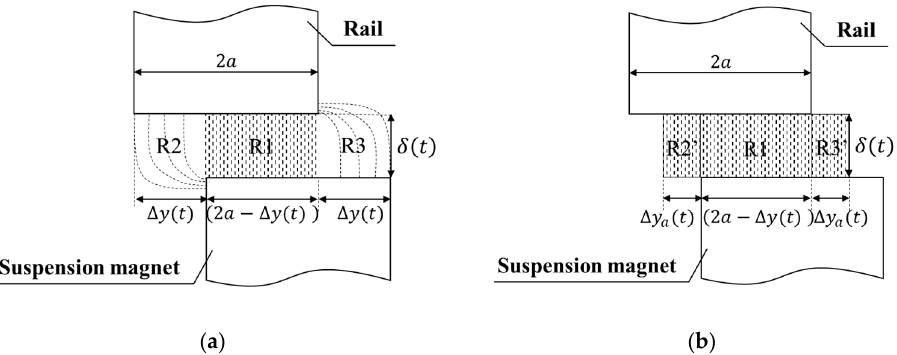
Figure 1. The single suspension magnet model. ( a ) The nominal state; ( b ) the state existing horizon- tal misalignment.